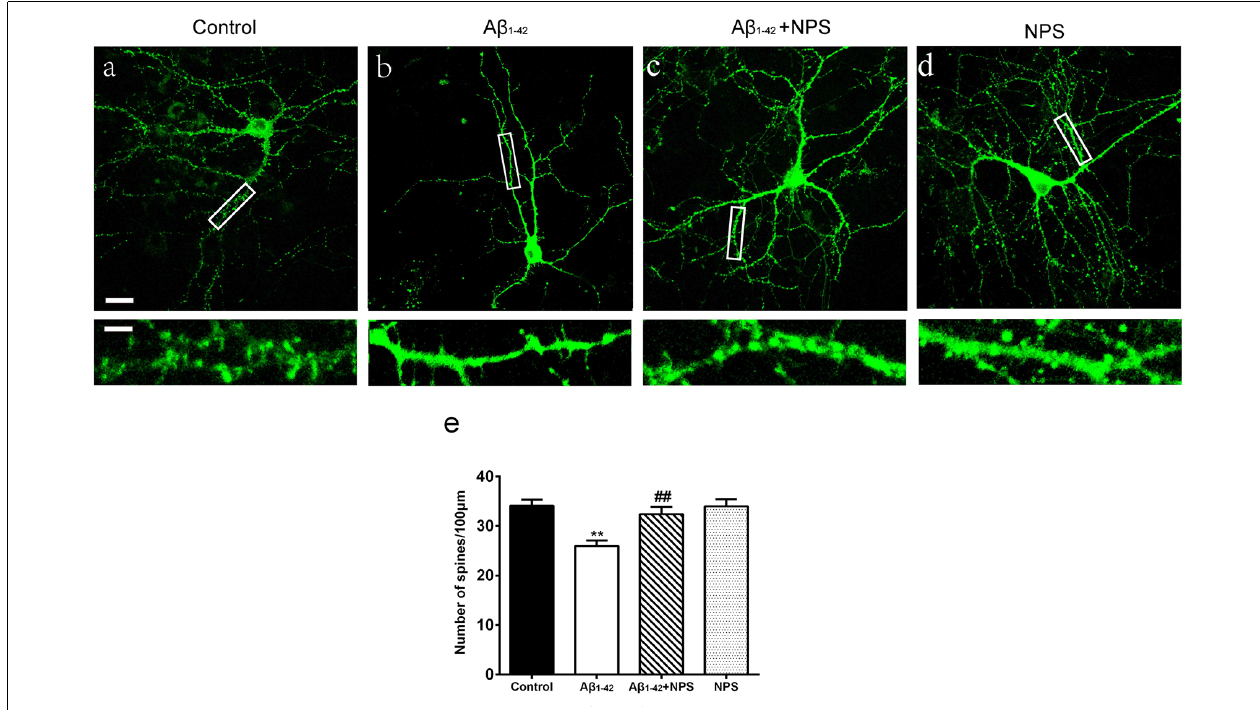
FIGURE 3 | NPS 2143 protected hippocampal neurons from soluble A β 1–42 oligomer-induced spine loss at DIV 14. Structural morphology of the spine of hippocampal neurons was displayed by co-transfection of F-GFP and GFP-actin. Fluorescent figures captured by confocal were displayed with the control group (A) , the 0.5 µ M A β 1–42 group (B) , the 0.5 µ M A β 1–42 + 0.1 µ M NPS 2143 group (C) and the 0.1 µ M NPS 2143 group (D) . Scale bar 20 µ m and 5 µ m. (E) Quantitative comparison of the density of the dendritic spine of the four groups. ** P < 0.01 vs. control group, ## P < 0.01 vs. A β 1–42 oligomer-treated group. Values represent mean ± SEM, n = 21–25 neurons from three independent primary cell culture